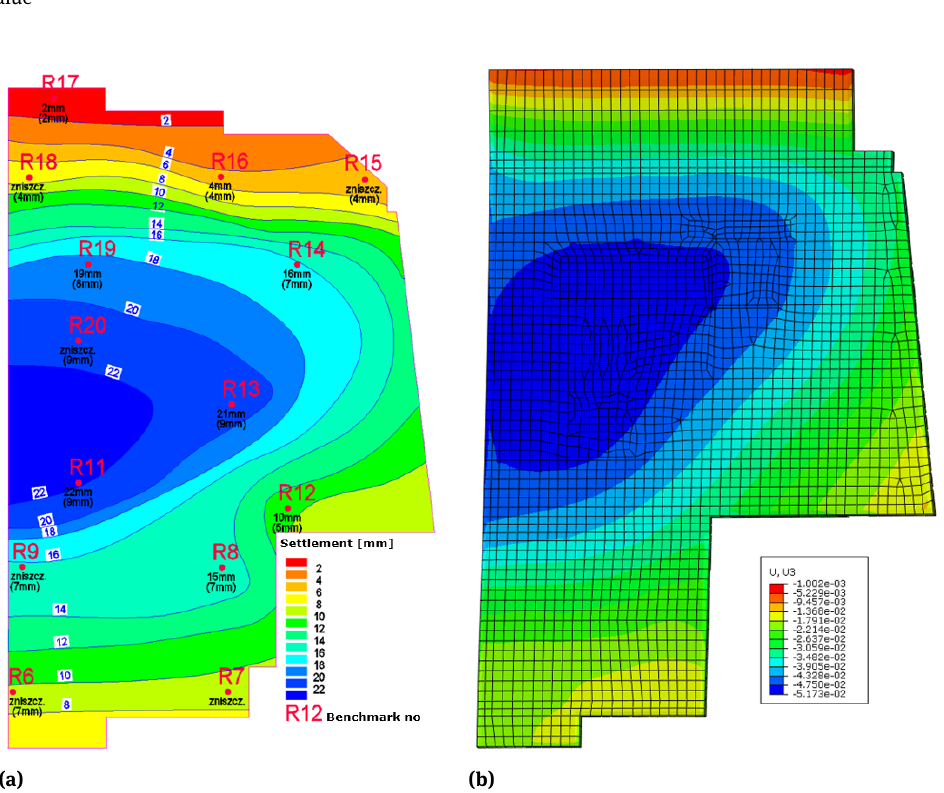
Figure 8: Map of the base-slab settlement on the basis of: a) measurements of the real actual settlement [mm], b) calculations in